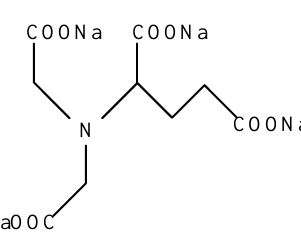
Figure 2. Chemical structural formula of glutamate diacetic acid (GLDA).